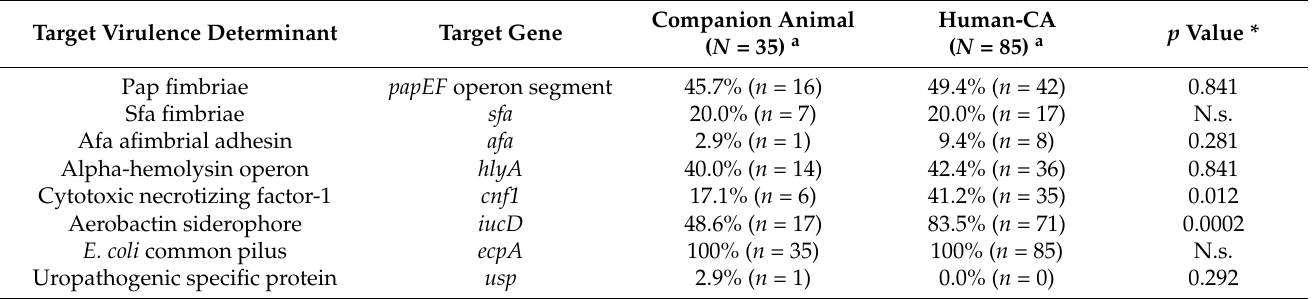
Table 6. Frequency of virulence genes among 3GC-resistant E. coli isolated from companion animals and humans with UTI.